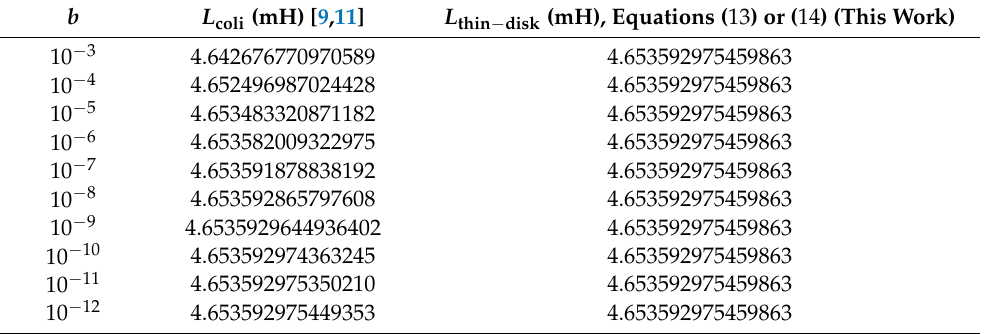
Table 1. The self-inductance when b is extremely decrasing. b L coli (mH) [9,11] L thin − disk (mH), Equations ( 13 ) or ( 14 ) (This